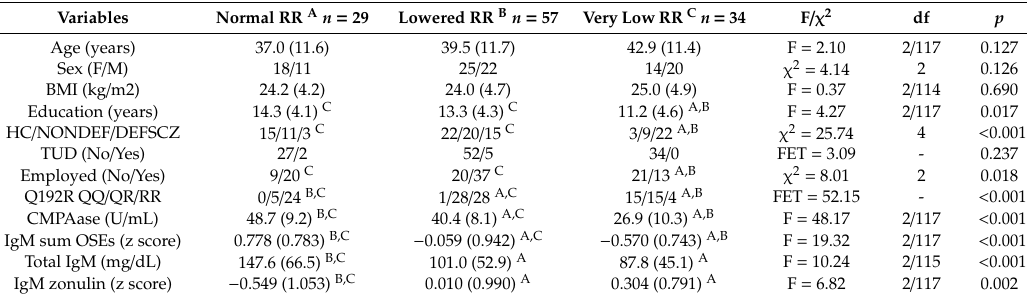
Table 1. Socio-demographic data of the participants in this study divided according to the risk resilience (RR)